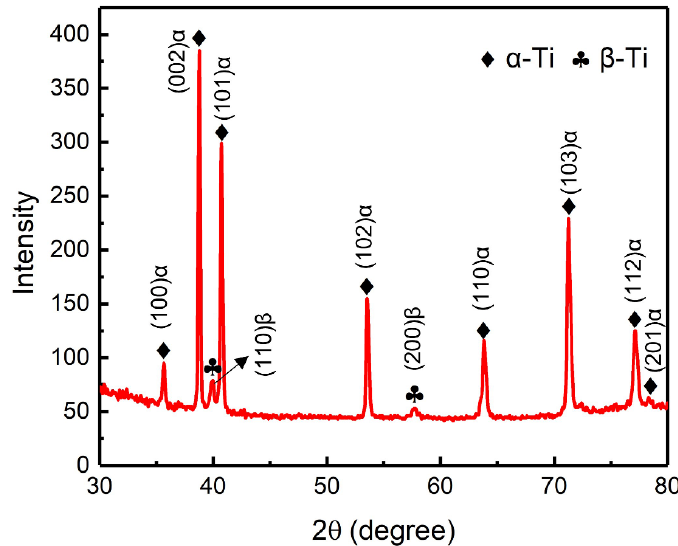
Figure 2. XRD pattern of the hot-rolled LD-Ti423 alloy.